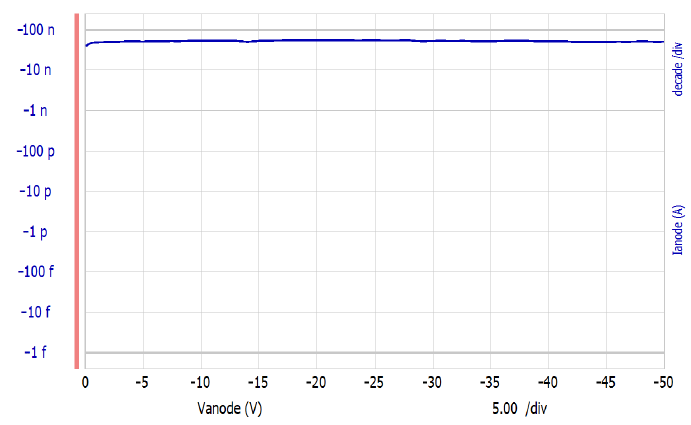
Figure 7. The reverse I-V characteristic curve test results of the 2CZ106C.